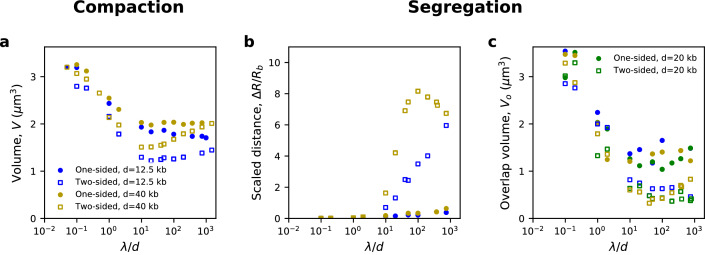
Measures of compaction and segregation with different densities of LEFs.(a) Volumetric compaction of individual chromosomes and (b) scaled distance between the backbones of sister chromatids are shown for one-sided and two-sided extrusion (filled circles and open squares, respectively) with LEF densities of 1 per 12.5 kb (blue) and 1 per 40 kb (gold). (c) Sister chromatid overlap volume is shown as a supplementary measure of chromatid resolution. Overlap volume decreases as λ/d increases, but the decrease in volume is limited for chromatids compacted by one-sided extrusion (filled circles) as compared to those compacted by two-sided extrusion (open square).